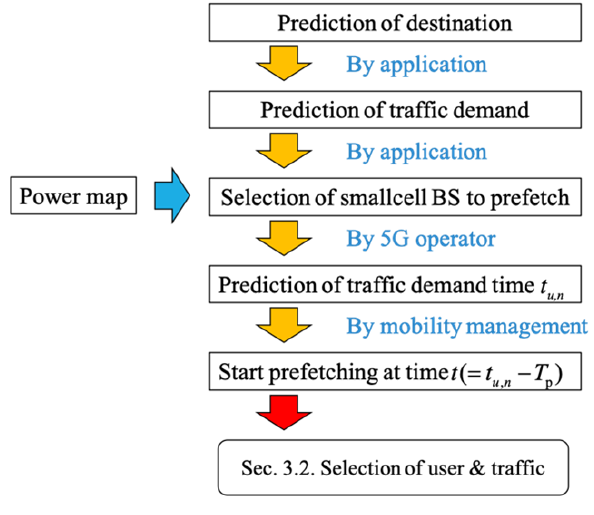
Figure 5. The pre-association process.